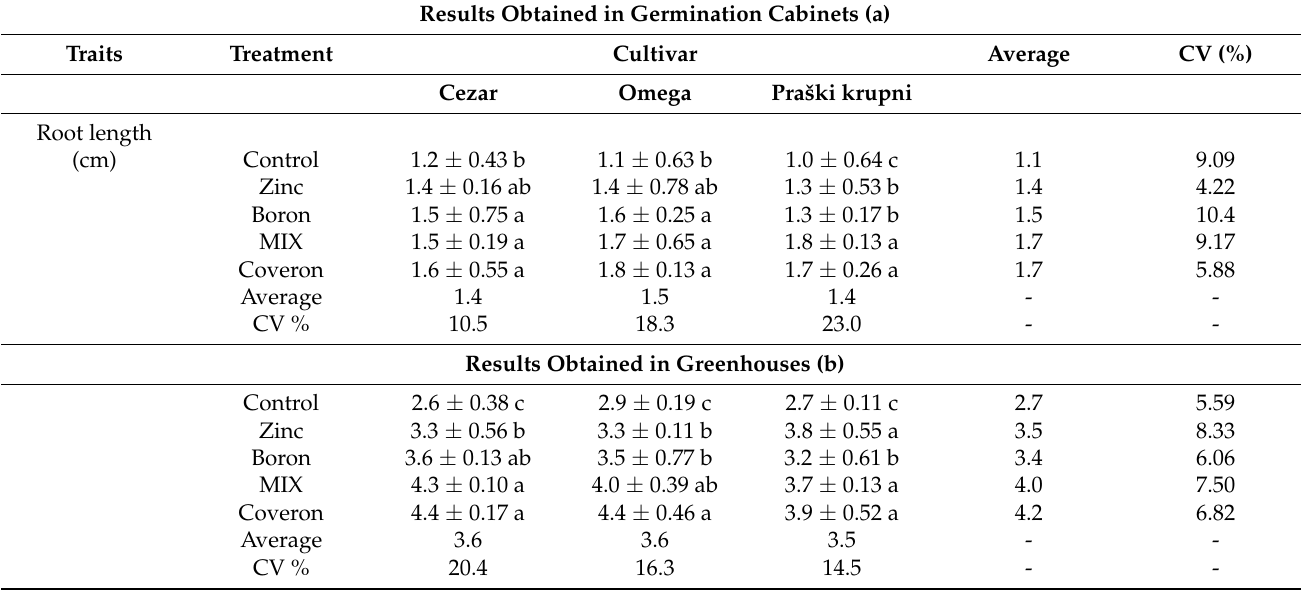
Table 7. Growth of root length after treatments applied to celeriac cultivars.